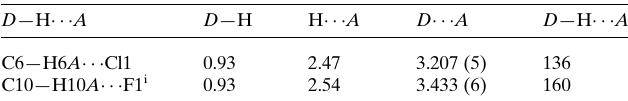
Table 1 Hydrogen-bond geometry (A˚ , (cid:2) ).